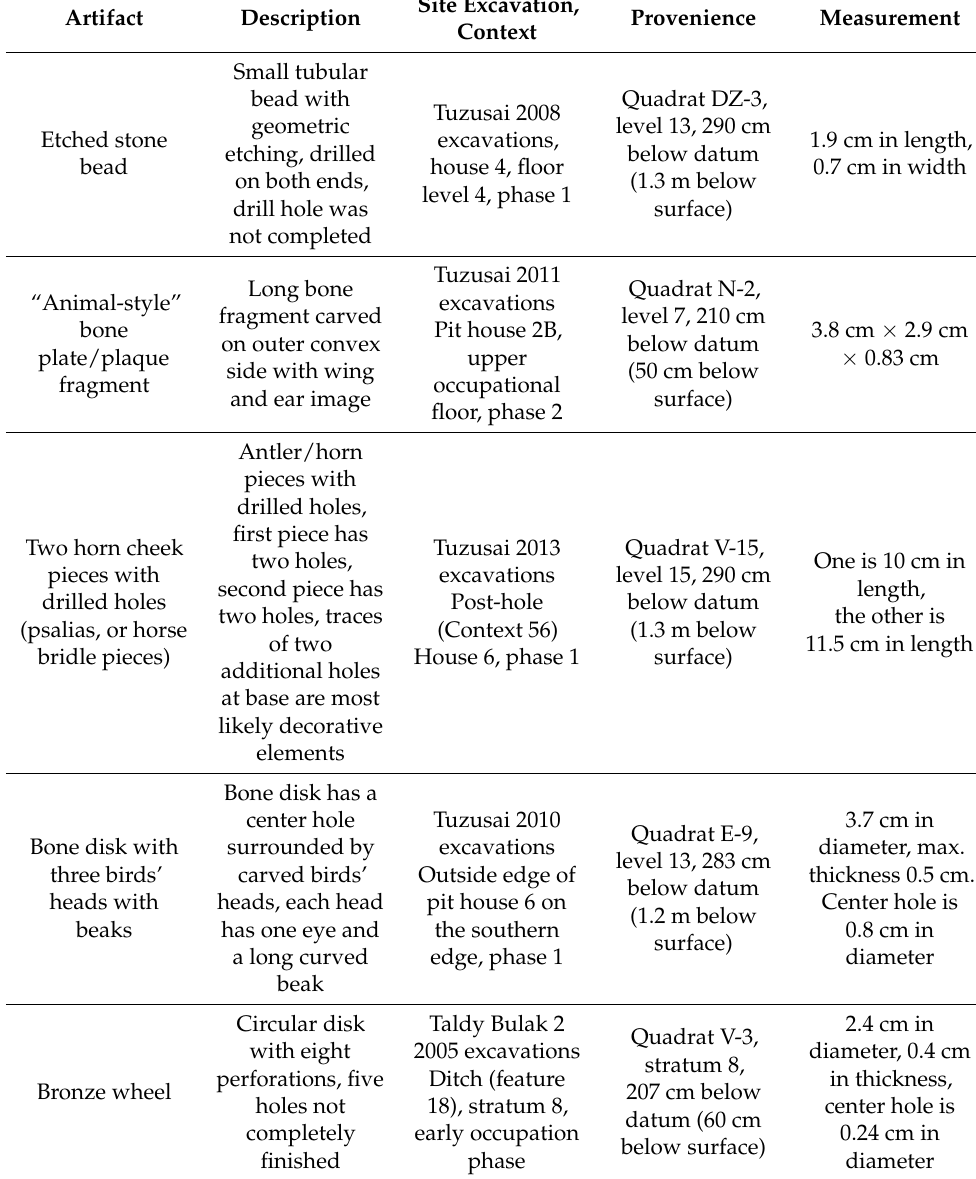
Table 1. List of special finds, context and feature association, and